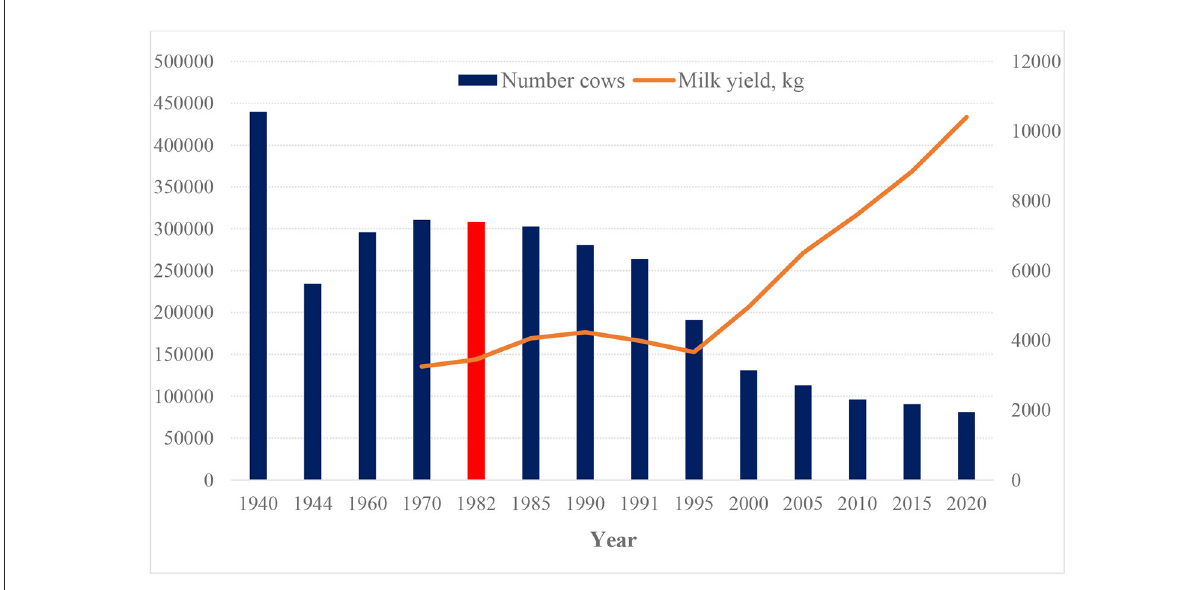
FIGURE2 Number of cows and mean milk yield per cow between 1940 and 2020. There are no official data about milk production available from 1944 to 1960. Data from: